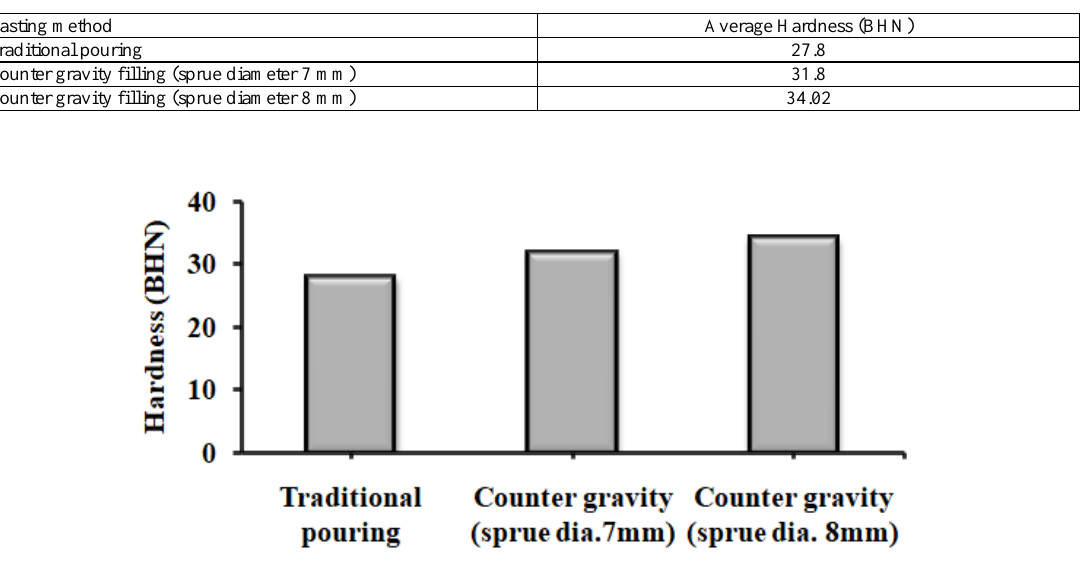
Table 2. Hardness of samples